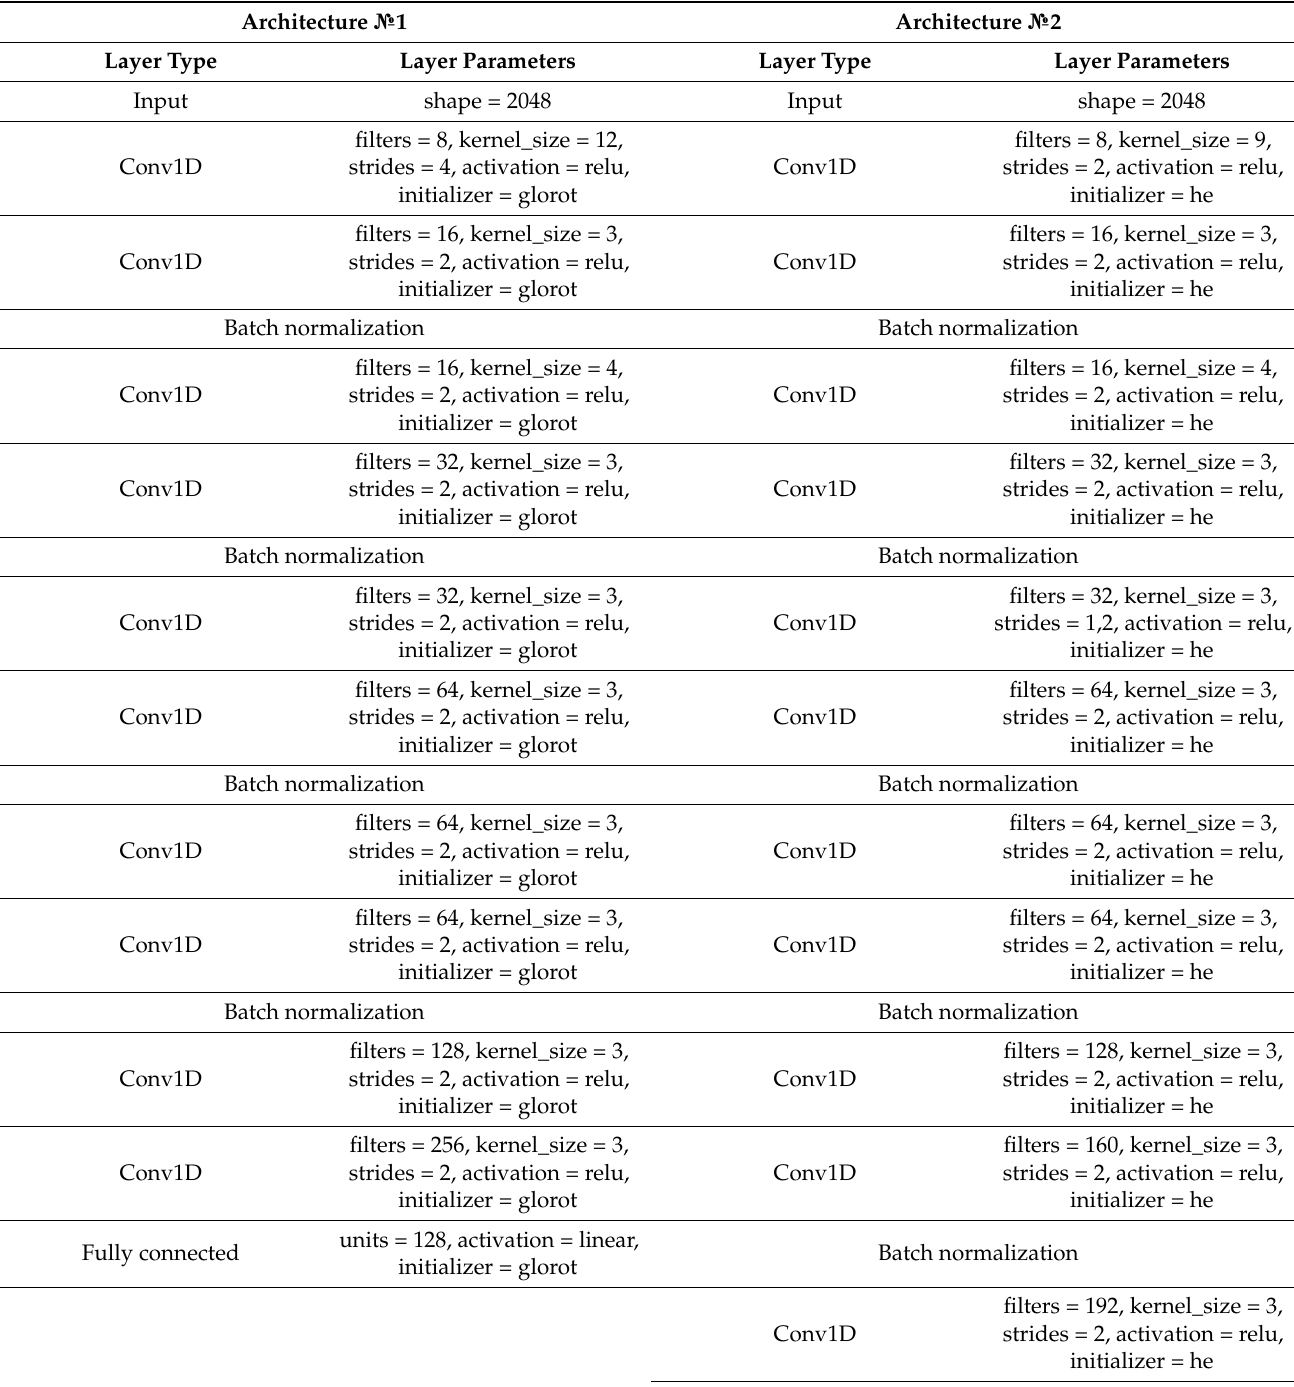
Table 2. Configurations of